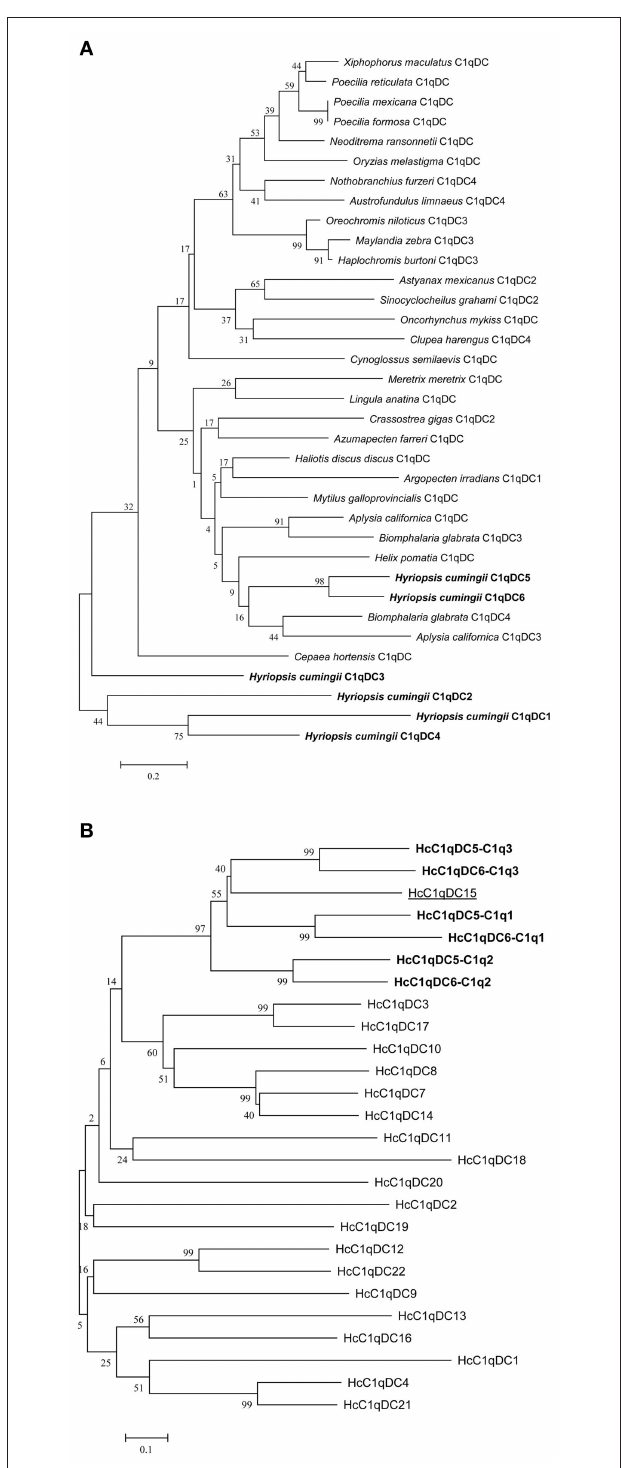
FIGURE 3 | (A) Phylogenetic tree analysis of HcC1qDC6 and other representative C1qDC proteins. C . gigas C1qDC2, Accession No. EKC25478.1; B . glabrata C1qDC4, Accession No. XP_013091954.1; Haliotis discus discus C1qDC, Accession No. ABO26662.1; M . galloprovincialis C1qDC, Accession No. CBX41690.1; A. californica C1qDC, Accession No.